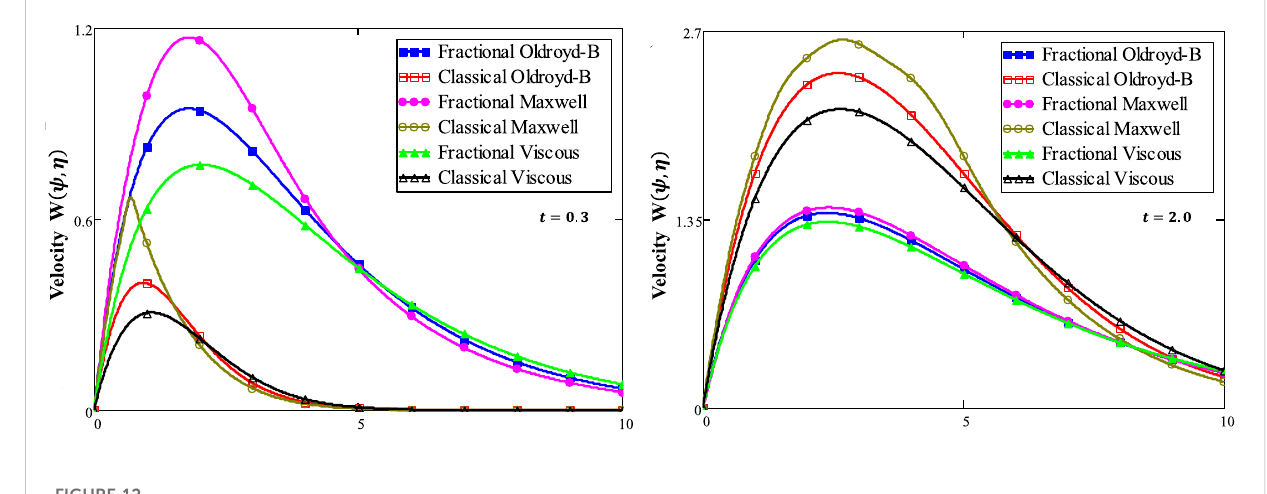
FIGURE 12 Simulation to explain the velocity for the different fl uid models when Pr (cid:3) 3 . 2 , ϕ 1 (cid:3) ϕ 2 (cid:3) 0 . 2 , Gr (cid:3) 8 , Gm (cid:3) 4 . 5 , Sc (cid:3) 0 . 1 , λ 1 (cid:3) 0 . 7 , and λ 1 (cid:3) 0 . 3.